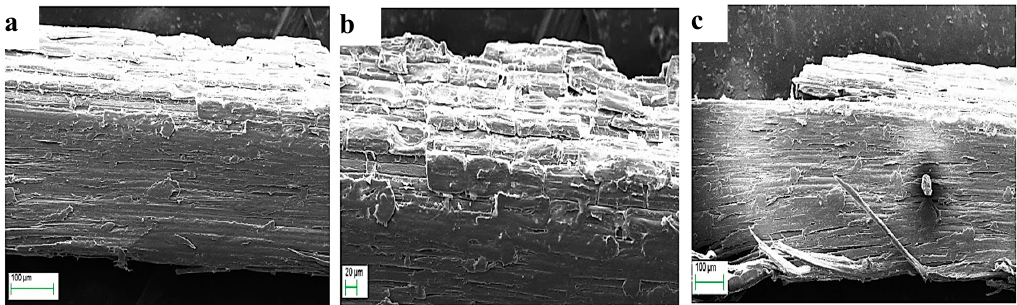
Figure 3. Microstructure of the surface of the single-cellulosic Buluh semantan strips after soaking for 12 h in 4 wt.% NaOH showing in ( a ), and ( b ) b cellular elements on the clean fiber surface after alkali treatment in di ff erent magnification, ( c ) shows relatively rough surfaces.